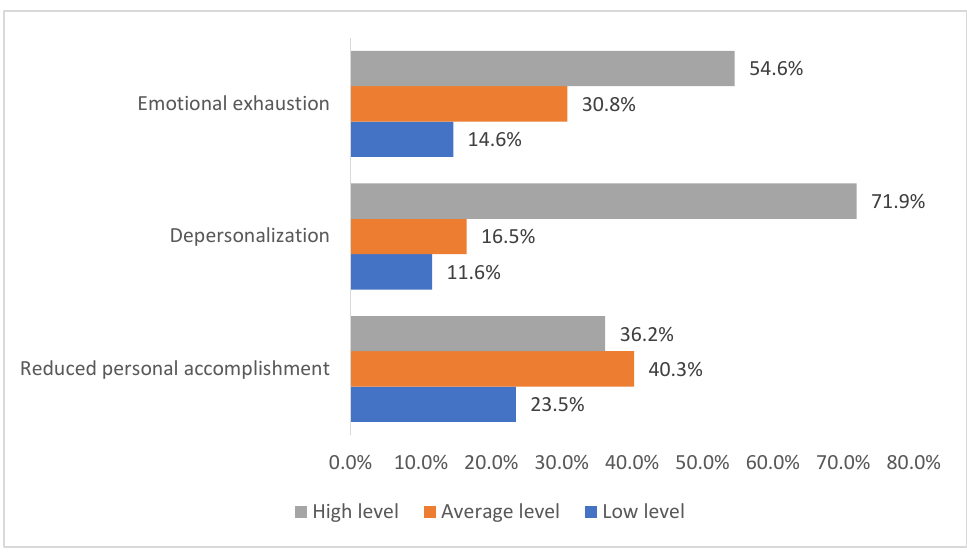
Figure 1. The frequency distribution of HCWs of non-COVID-ICU by the levels of severity of occupational burnout components.